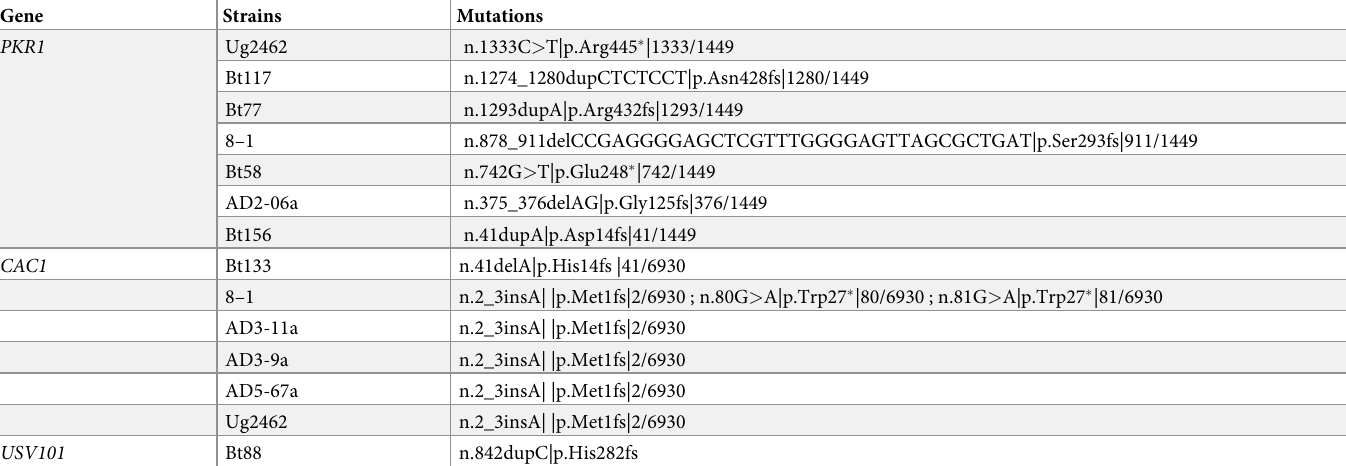
Table 3. Mutations of PKR1 , CAC1 , USV101 in specific clinical isolates.